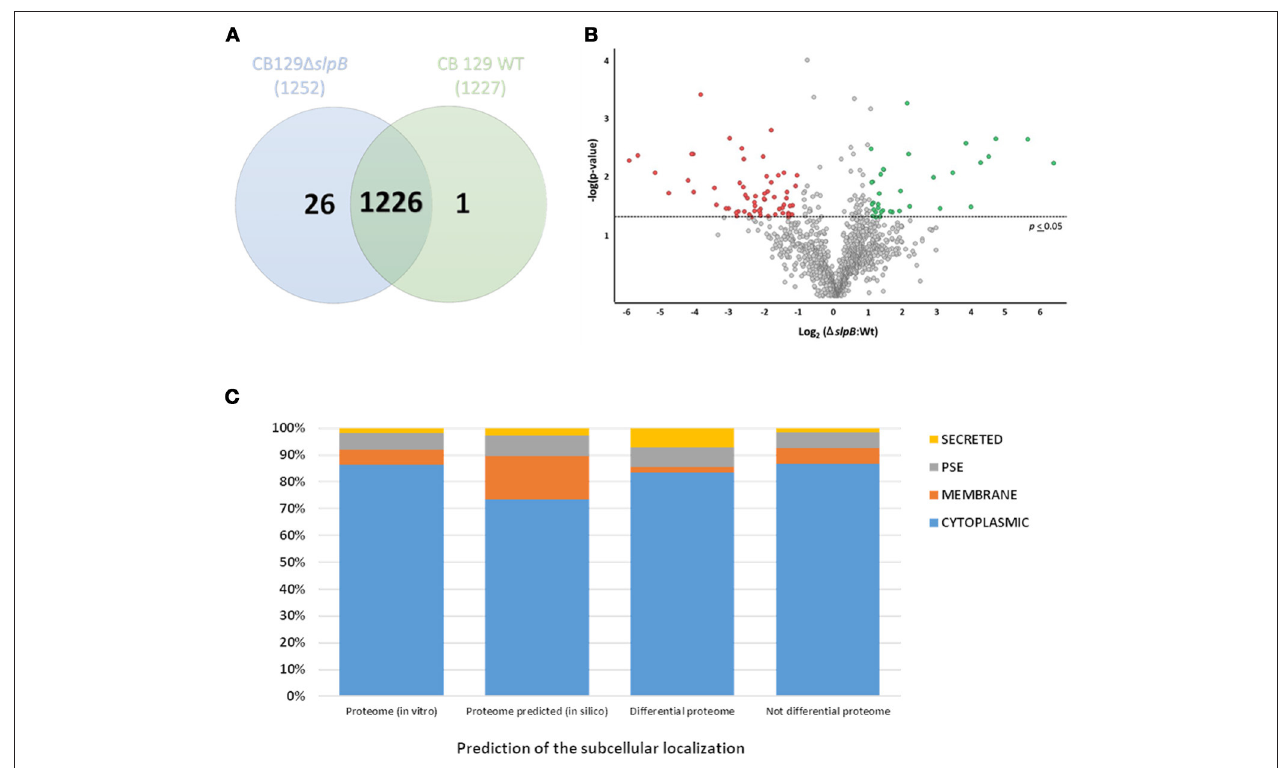
FIGURE 4 | Label-free quantification of proteins from P. freudenreichii CIRM-BIA 129 and CB 129 1 slpB strain. (A) Distribution of the proteins identified in the proteome of WT and CB129 1 slpB strains, represented by a Venn diagram. (B) Volcano Plot showing Log(2) Fold Change of the differentially expressed proteins in CB129 1 slpB strain in relation to WT strain. Green (up-regulated proteins) and red circles (down-regulated proteins) represent proteins statistically different ( p ≤ 0.05, ANOVA) in abundance between strains by 2-fold or more. (C) Prediction of the subcellular localization of the proteins identified by LC/MS and organized as cytoplasmic (CYT), membrane (MEM), potentially surface-exposed (PSE) or secreted proteins